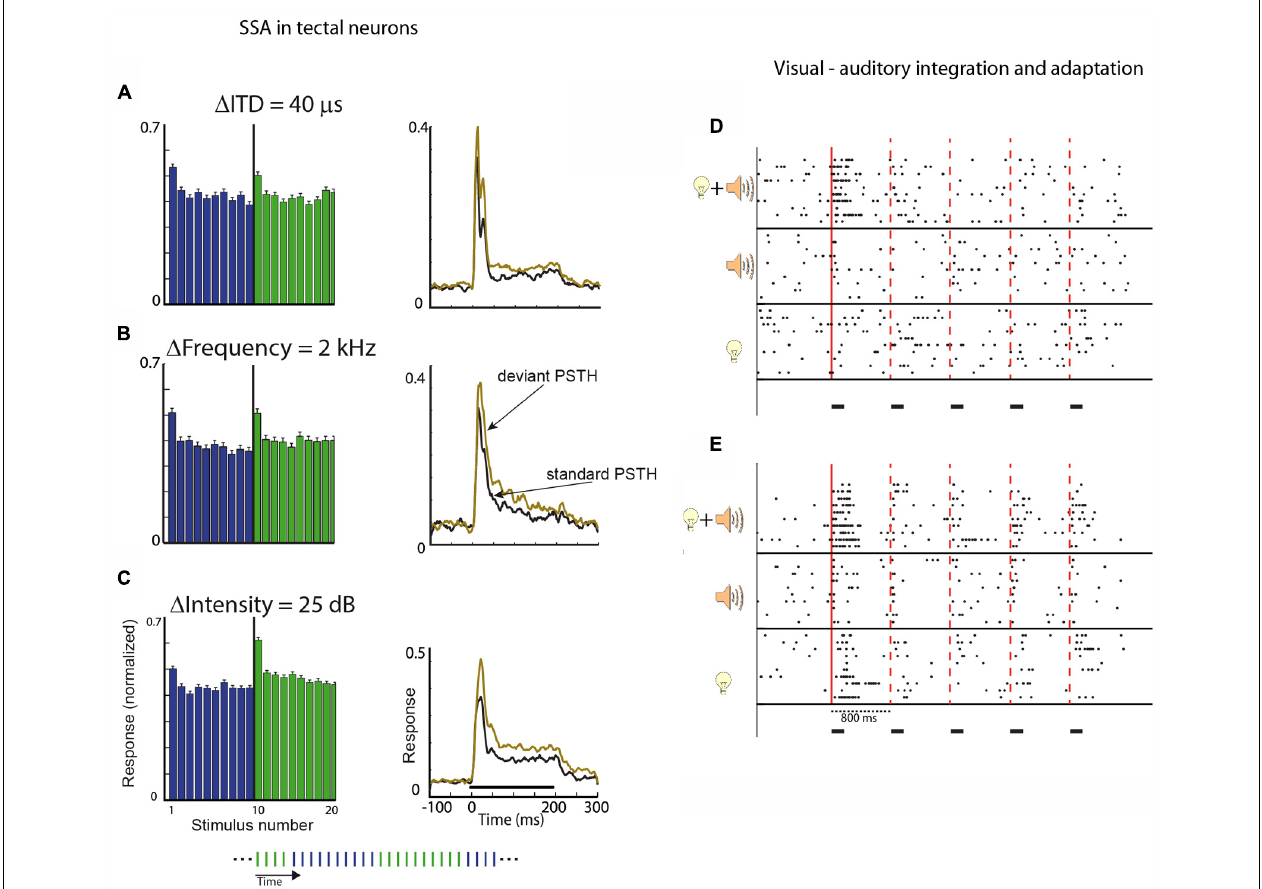
cases. Modified with permission from Reches and Gutfreund (2008). (D,E) Two examples of tectal recordings showing bimodal enhancement.The raster plots show results of unit responses to a sequence of five repetitions of a stimulus with an ISI of 800 ms.The time course of stimulation is designated by the horizontal black bars. Stimuli were either five visual stimuli, five auditory stimuli, or five congruent bimodal stimuli (visual and auditory stimuli appearing together from the same location).The solid vertical line designates the onset of the first stimulus in the sequence.The dashed vertical lines designate the onset of subsequent stimuli. In both examples (D,E) , stronger responses to bimodal stimuli can be seen in the response to the first stimulus in the sequence compared to the unimodal responses.This bimodal enhancement is missing in the responses to the subsequent stimuli. Modified from Zahar etal.